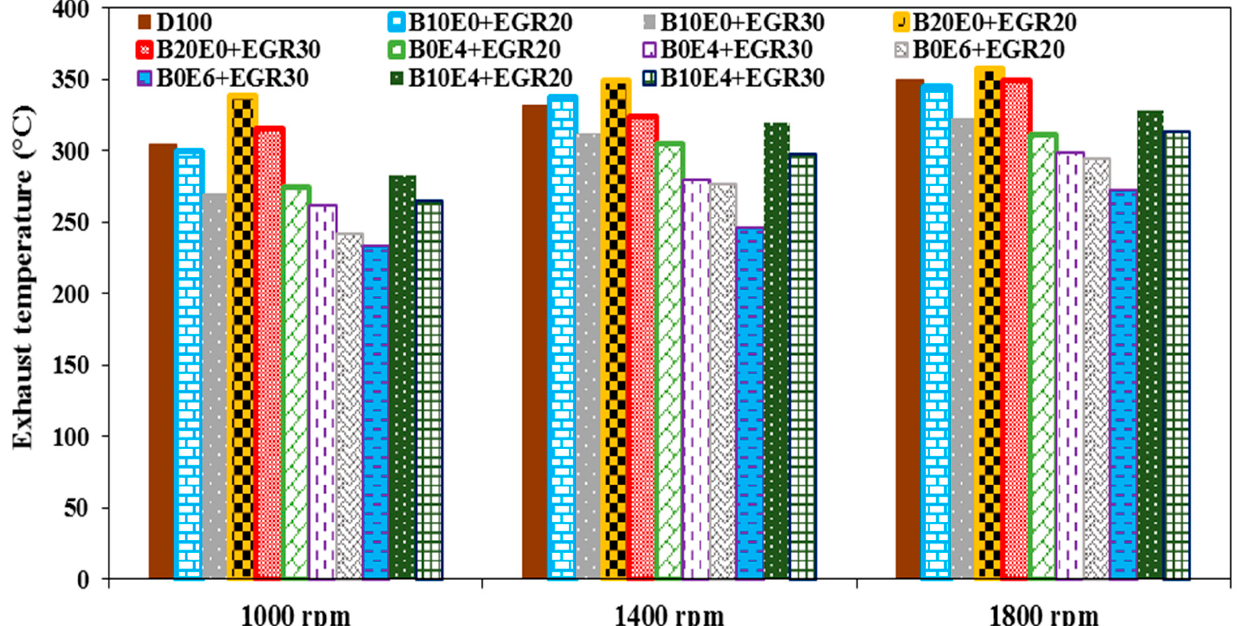
Figure 8. Variation of exhaust temperature for diesel/ethanol/biodiesel blends at EGR = 20, 30%, and various engine speeds.